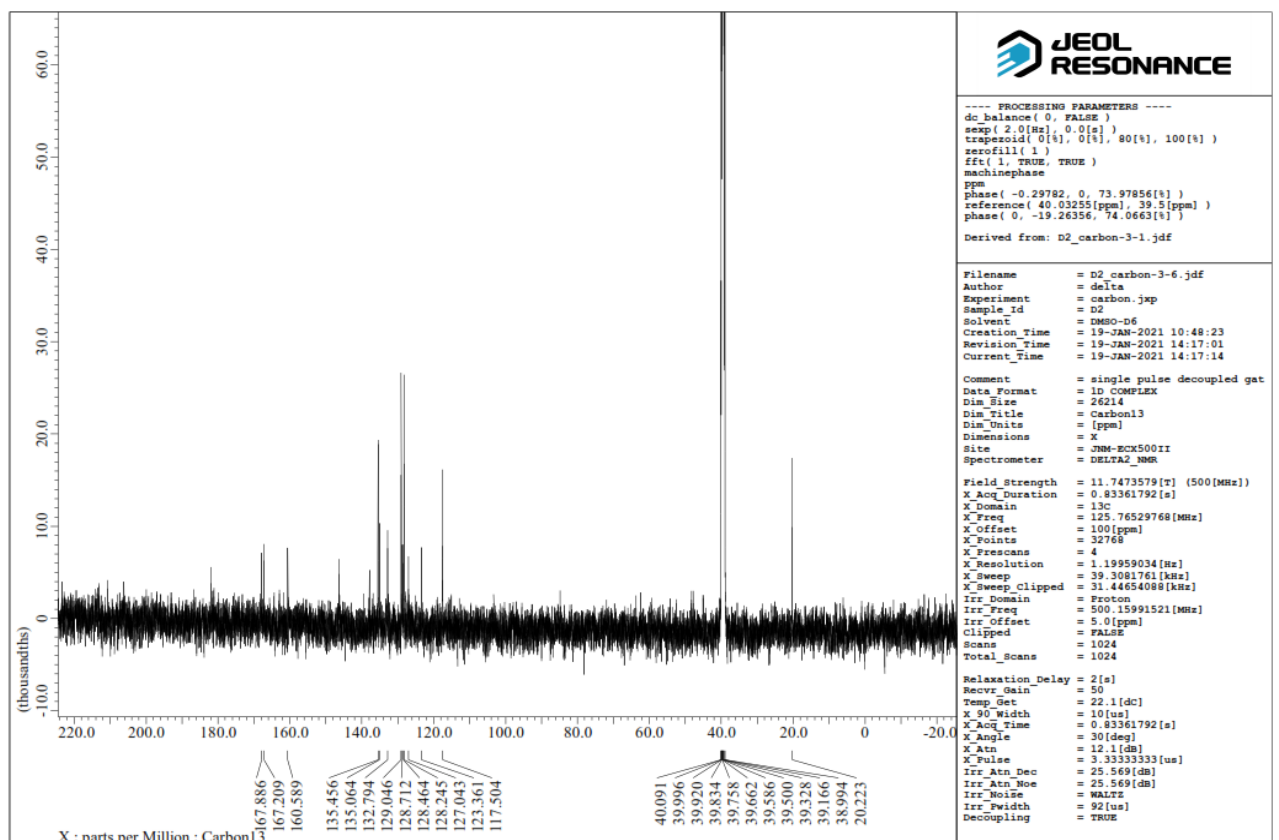
Figure 2. 1 H-NMR of compound 4.